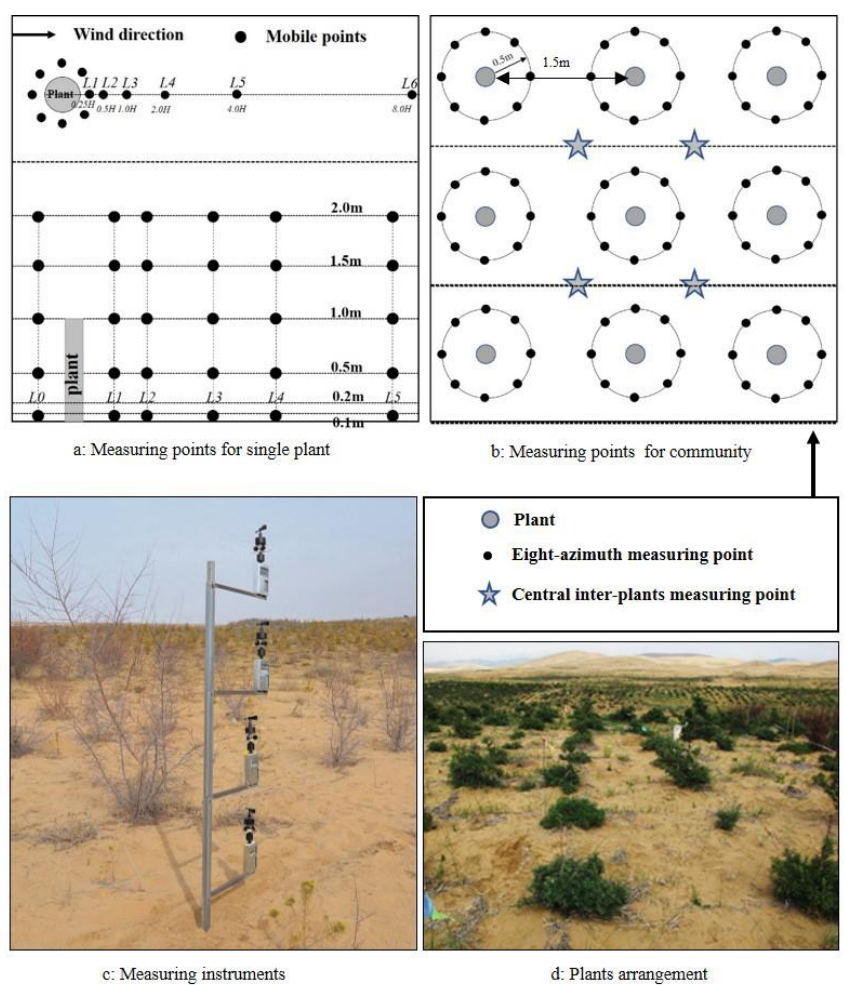
Figure 3. Measuring points for individual plants ( a ) and between plants ( b ), as well as the measuring instruments ( c ) and plant arrangement ( d ).